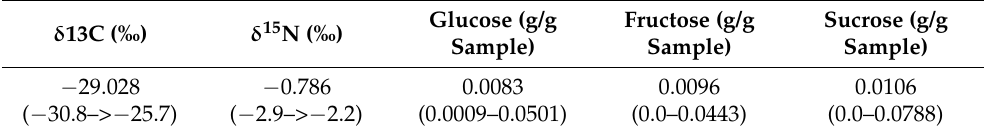
Table A1. Average phytochemical values of whitebark pine needles. Numbers are means (ranges given in